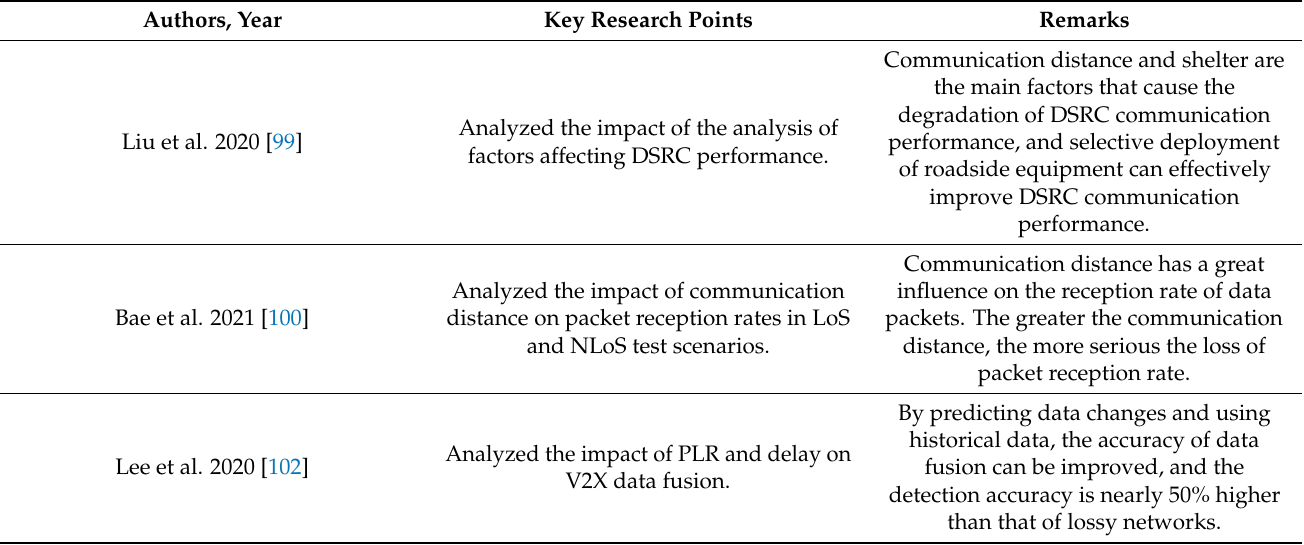
Table 8. Summary of the possible impact of network performance on cooperative